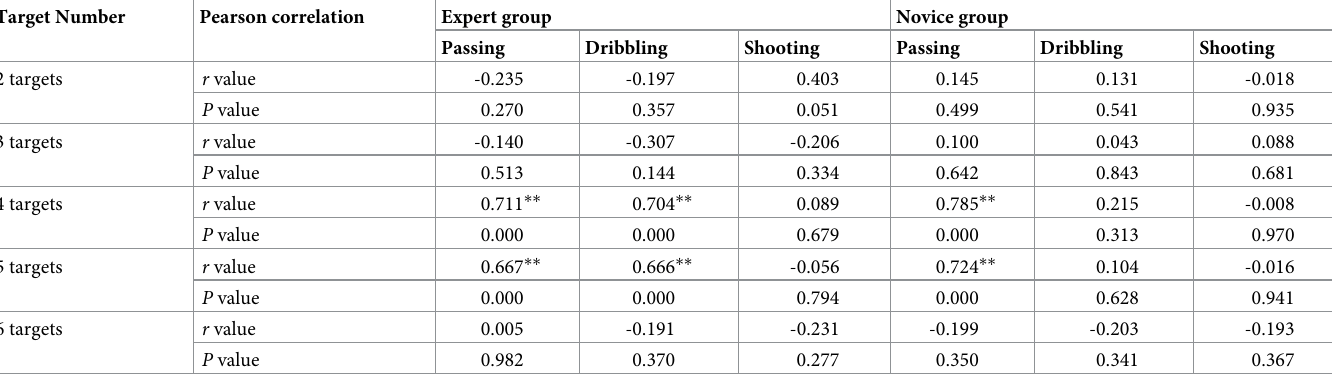
Table 3. Correlation between MOT ability and SDM performance among basketball